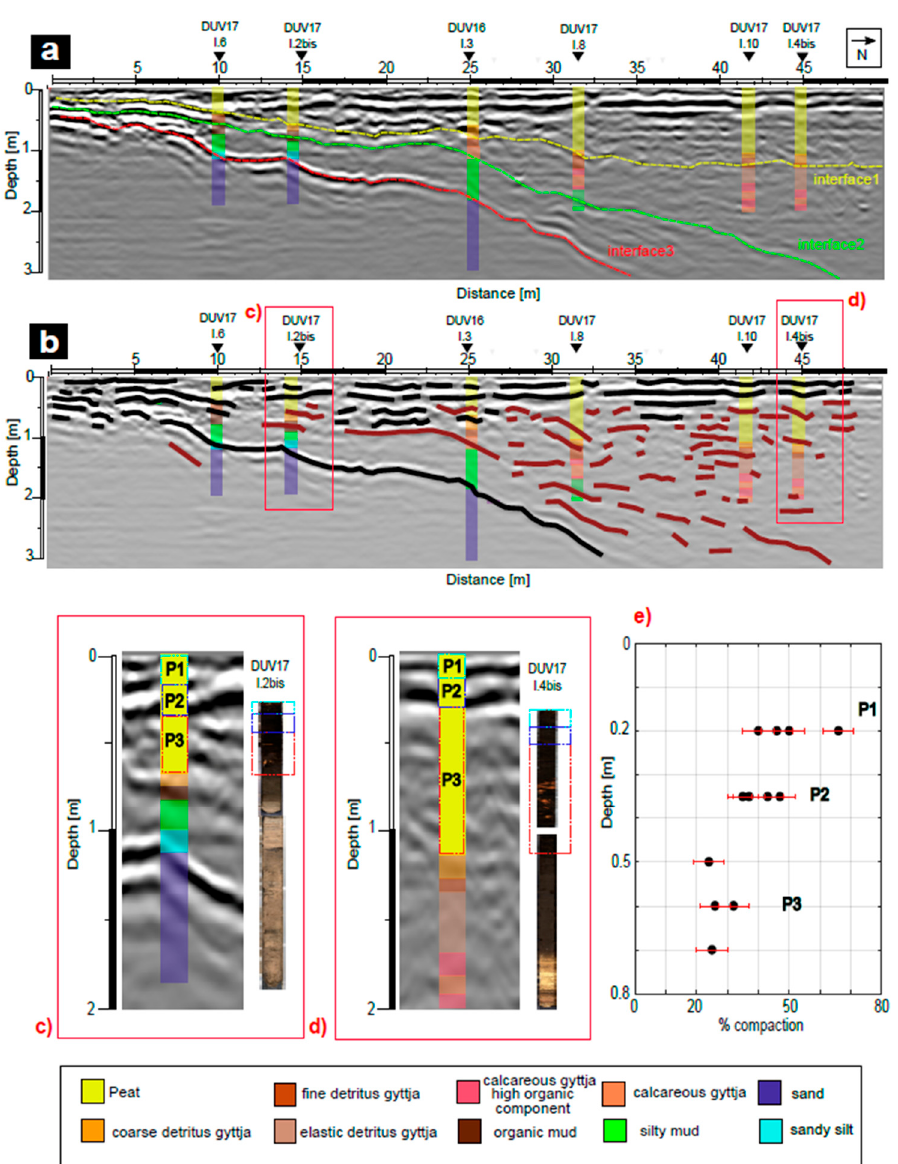
Figure 4. GPR results for the reference profile. ( a ) GPR profile including the recognized interfaces (after [31]); ( b ) GPR profile with interpretation of the visible reflections, the black lines indicate stronger-amplitude reflections, and the dark red lines indicate the reflections with a lower amplitude; ( c ) focus on core I.2bis together with GPR; ( d ) focus on core I.10 together with GPR. In all cores, the compression of the peat layer has been reconstructed using the depth of the GPR reflections; ( e ) estimation of the peat compaction caused by the drilling process. The original layer thicknesses were determined from the travel times of GPR reflections, which were then compared with the compacted thicknesses measured after the extrusion on the drill core. The error interval due to the uncertainty from the GPR velocity determination is reported,